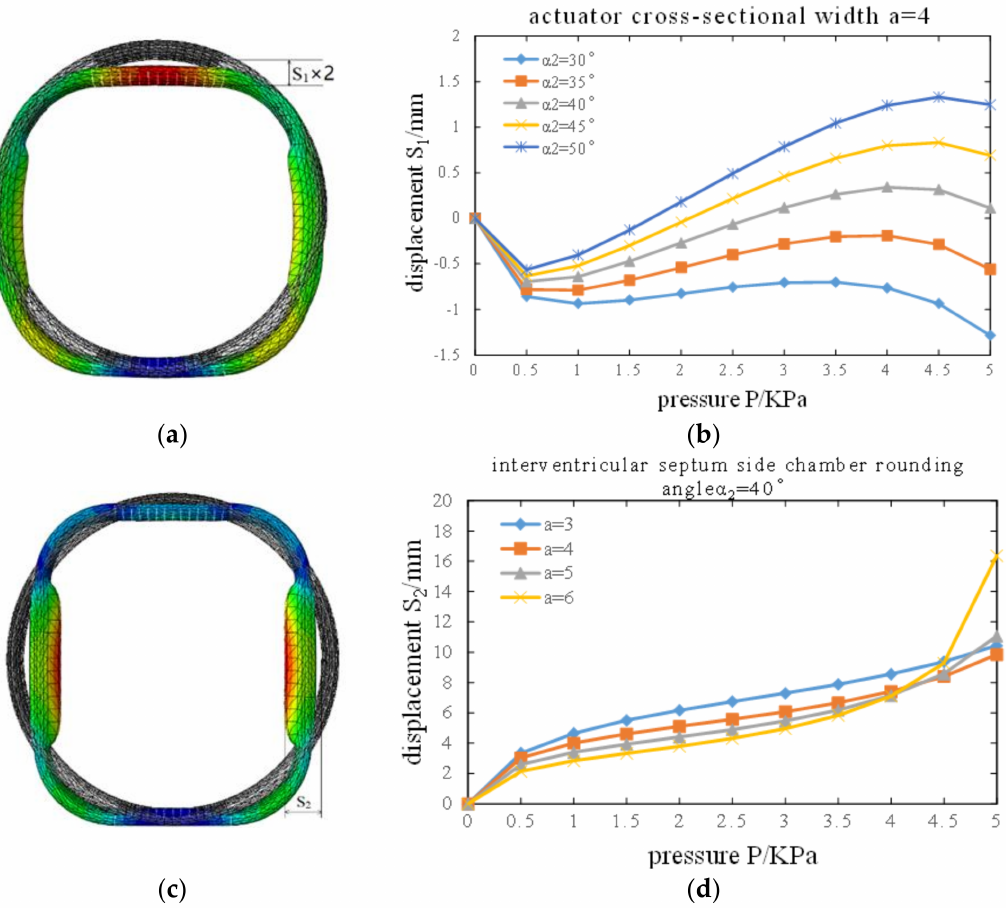
Figure 6. Optimization results for the structural parameters of fiber-constrained annular flexible actuators. ( a ) Circumferential flexible actuator ventricular-side balloon displacement S 1 ; ( b ) displace- ment of the actuator under different septal-side balloon rounding angles; ( c ) circumferential flexible actuator ventricular-side balloon displacement S 2 ; ( d ) lateral ventricular balloon displacement at different actuator section